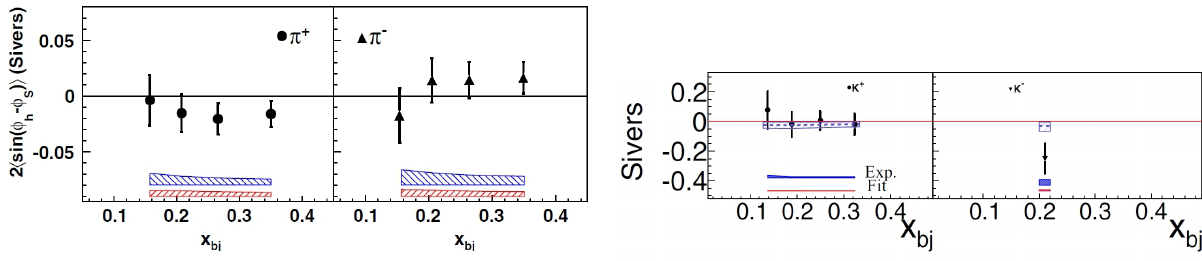
Figure 9. Hall A measurements of the Sivers asymmetries on neutrons for π ± (left) and K ±